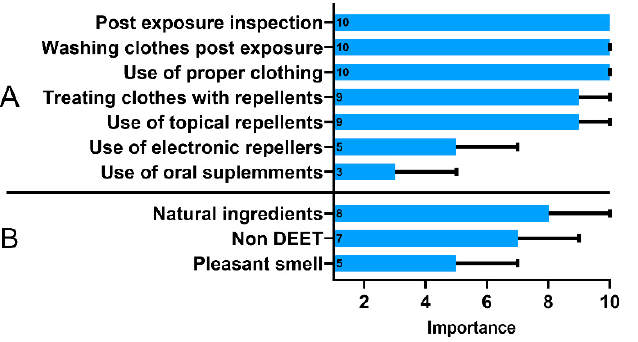
Figure 3. The importance of tick protection methods ( A ) and characteristics of a tick repellent ( B ) assessed using the 10-point Likert scale ranging from 1—“of little importance” to 10—“highly important”. Data presented as medians (boxes) and interquartile range (whiskers). The annotations within the bars represent the median values.